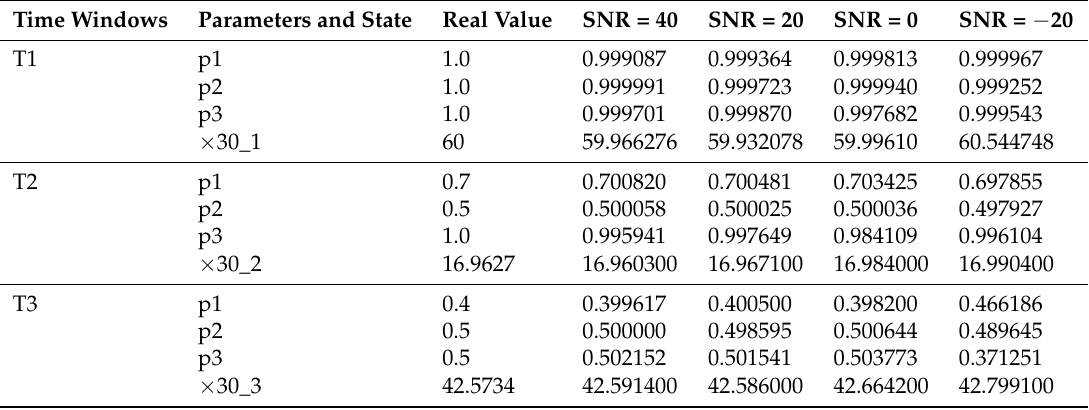
Figure 13. the relationship between the correlation coefficient and signal to noise ratio (SNR). Table 1. Euclide distance based State Estimation with different SNR in different time